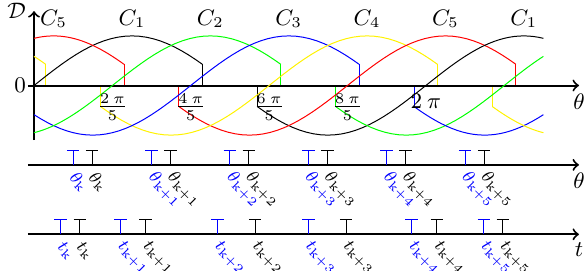
Figure 4: Displacement output response and control decision scheme of a full stroke operated DDM using both pumping and motoring strokes. Black samples are for motoring and blue samples are for pumping.